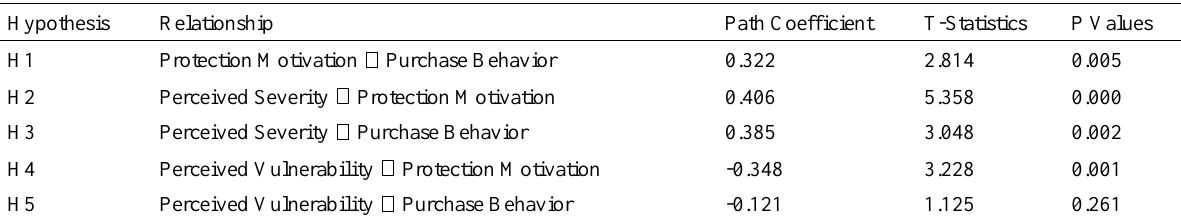
Table 4: Hypothesis Testing